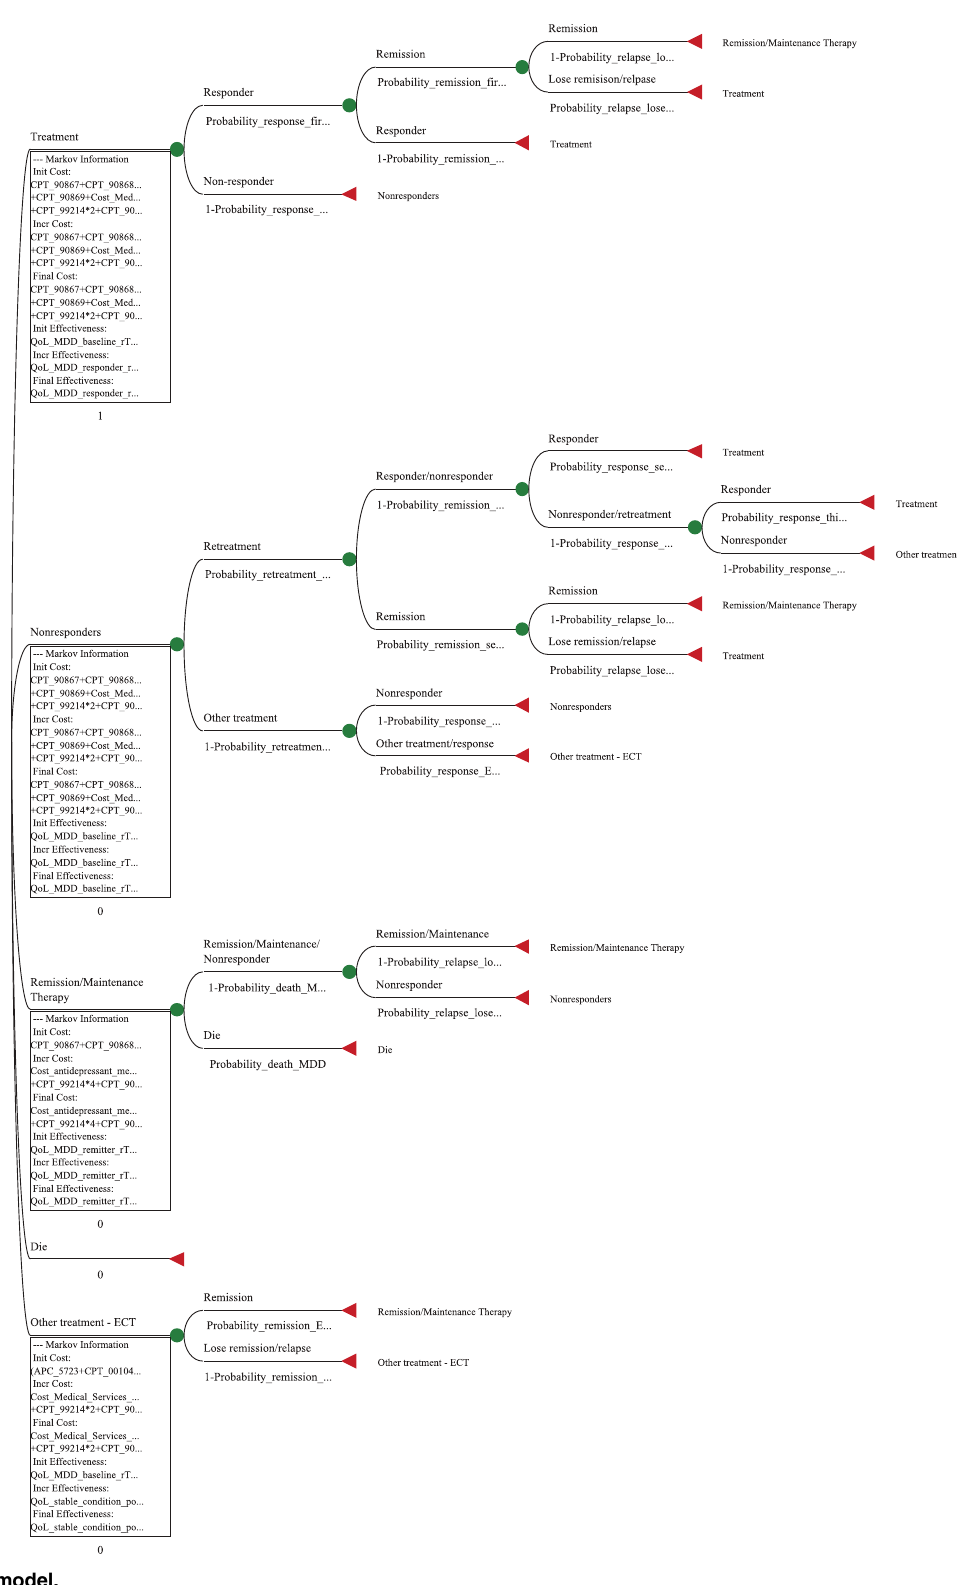
Fig 1. rTMS Markov model.